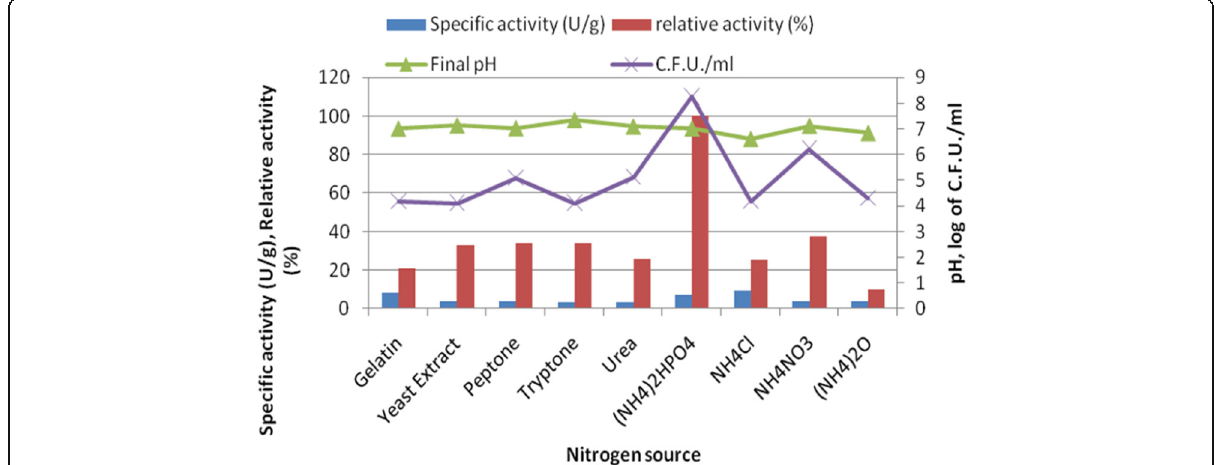
Fig. 4 Effect of different nitrogen sources on specific and relative activities of chitinase produced by S . maltophilia JF66 at optimum conditions